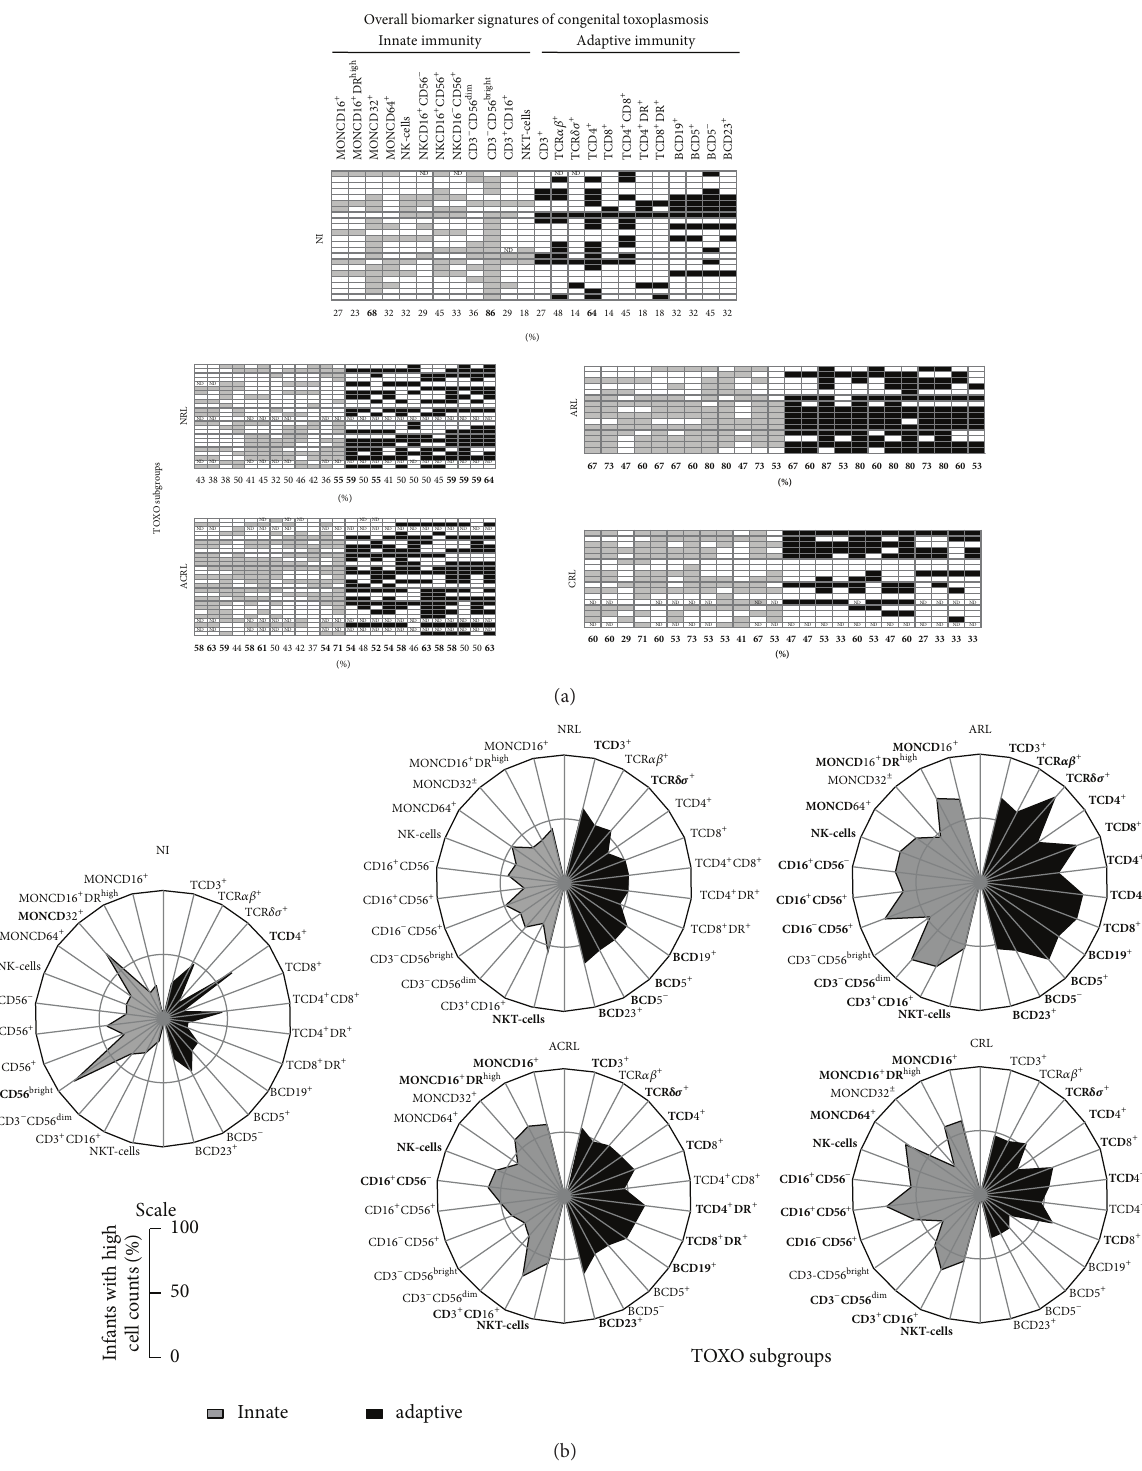
Figure 4: Biomarker signatures of innate and adaptive immunity in the peripheral blood of infants with congenital toxoplasmosis categorized as no retinochoroidal lesions (NRL), active retinochoroidal lesions (ARL), active/cicatricial retinochoroidal lesions (ACRL), and cicatricial retinochoroidal lesions (CRL) compared to noninfected controls (NI). (a) Gray-scale diagrams were assembled using the global median value of each cell subset as the cut-off mark to tag each infant as presenting “low” or “high” (innate; adaptive) levels of a given cell population. The frequency (%) of infants displaying high cell counts is provided, and the relevant data ( > 50%) are underscored in bold/underline format. (b) The radar charts summarize the biomarker signature of innate and adaptive immunity, where each axis displays the proportion of infants with high levels of a given cell population. The relevant data ( > 50%) are underscored in bold/underline